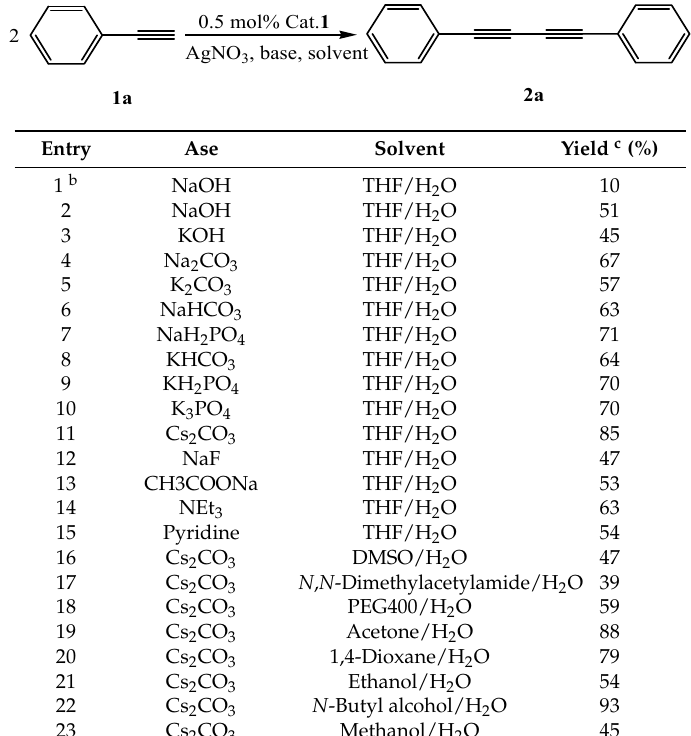
Table 1. Effects of solvent and base on the homocoupling of phenylacetylene a .